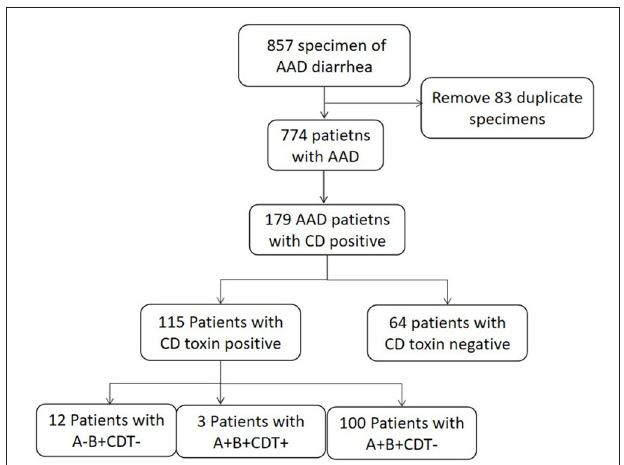
FIGURE 1 | The detailed procedures of patient enrollment and specimen screening processes.